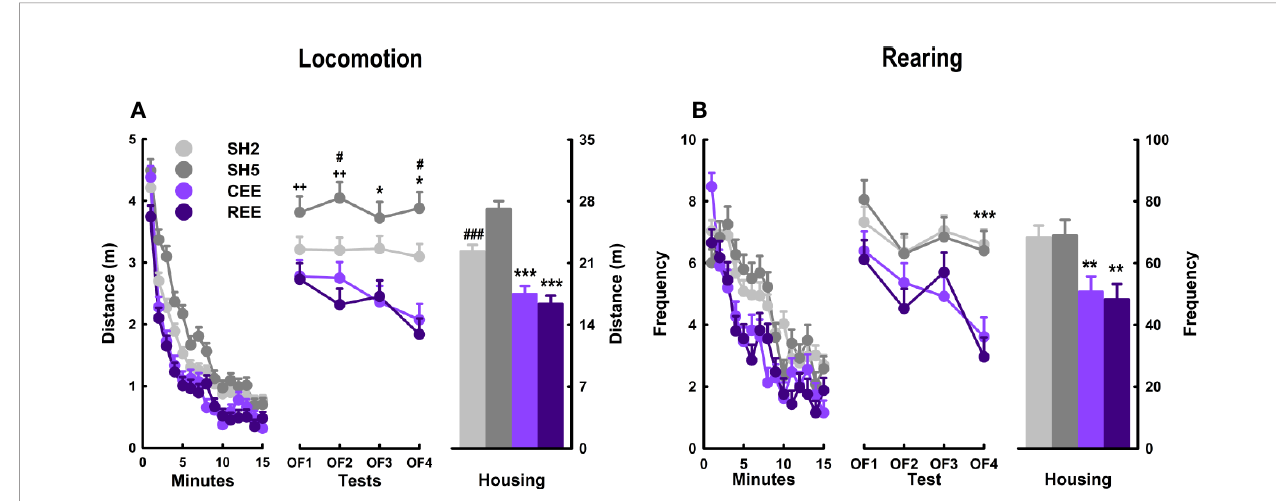
FIGURE 5 | Behavioral kinetics in the open- fi eld test. Locomotion (A) and rearing (B) over minutes (left panel), days (middle panel), and their cumulative averages (right panel). Data correspond to meters (A) and frequency (B) expressed as mean ± SEM. SH2: Standard housing with two rats. SH5, standard housing with fi ve rats. CEE: Continuous environmental enrichment; REE, restricted and unpredictable environmental enrichment. Single, pairwise-comparisons between groups, CEE and REE vs. SH2 and SH5: * p < .05; *** p < .001; SH2 vs. SH5: # p < .05; ### p < .001; and SH5 vs. CEE and REE: ++ p <